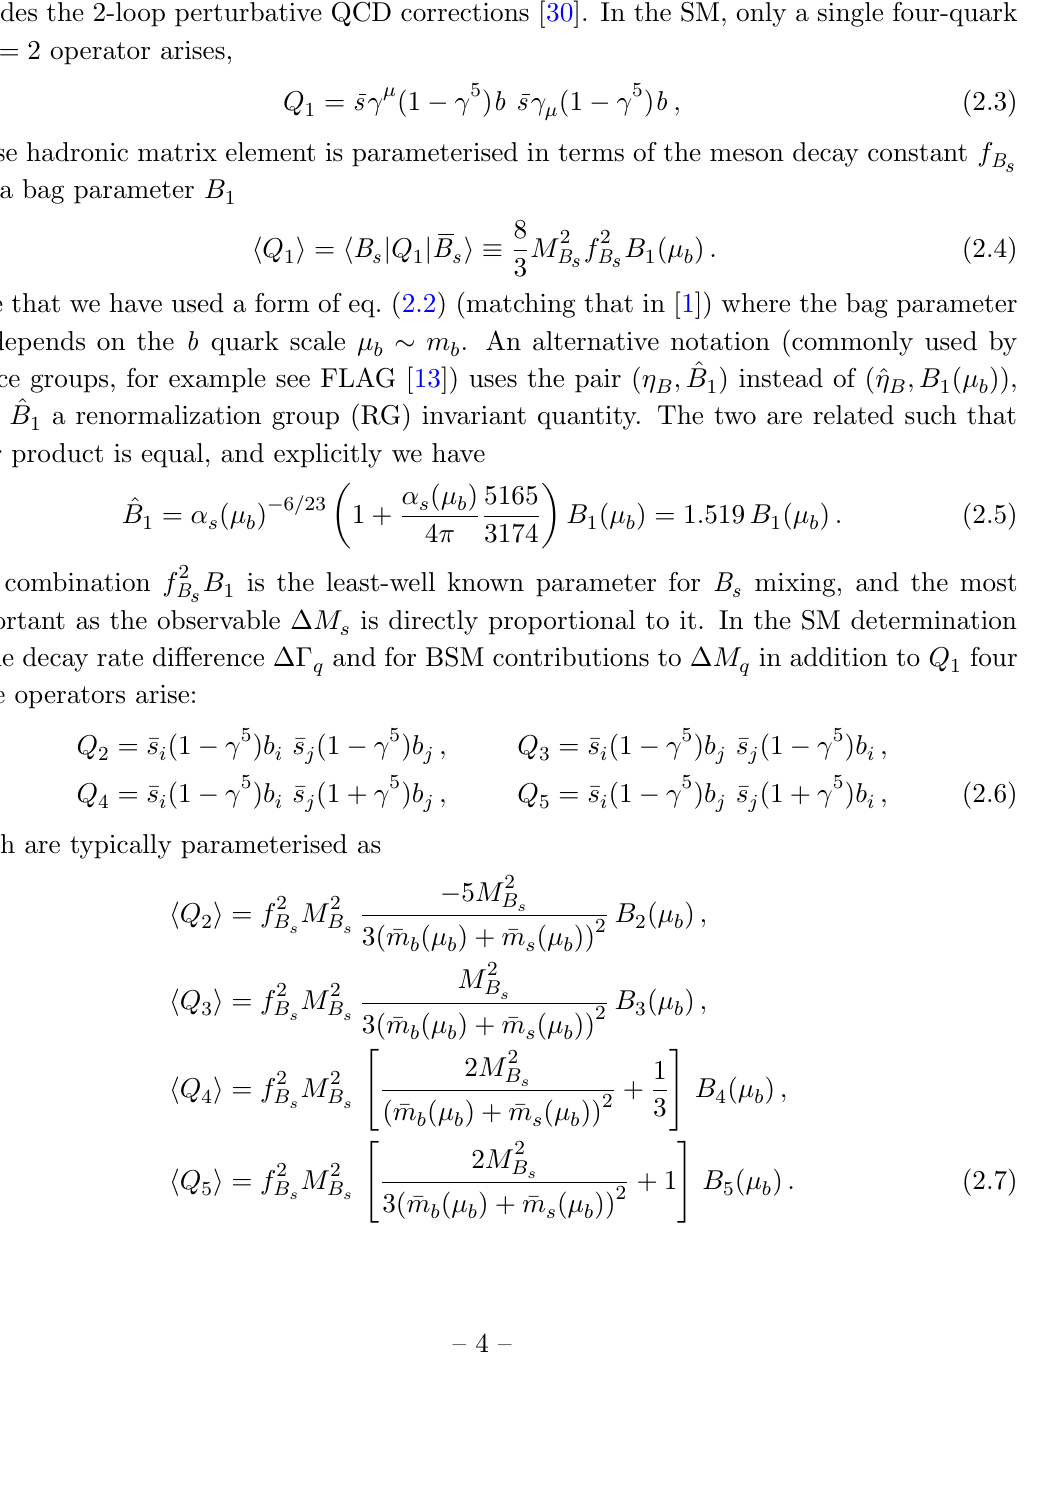
Figure 2 . Box diagrams that generate the B when the internal particles are